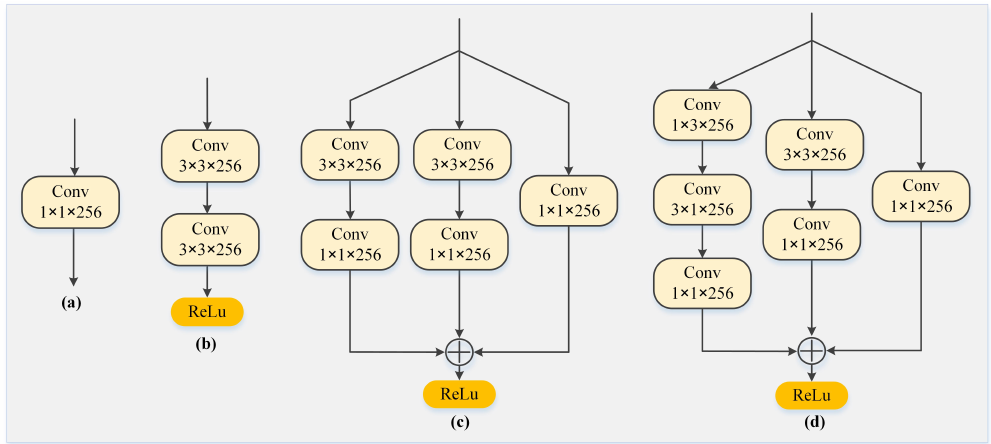
Figure 4. Different multi-scale semantic enhancement blocks. From left to right are ( a ) M_1 block,